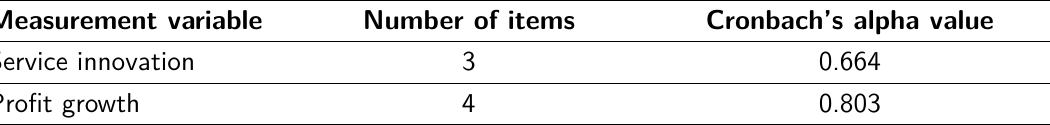
Table 2. Internal consistency reliability of measurement scales